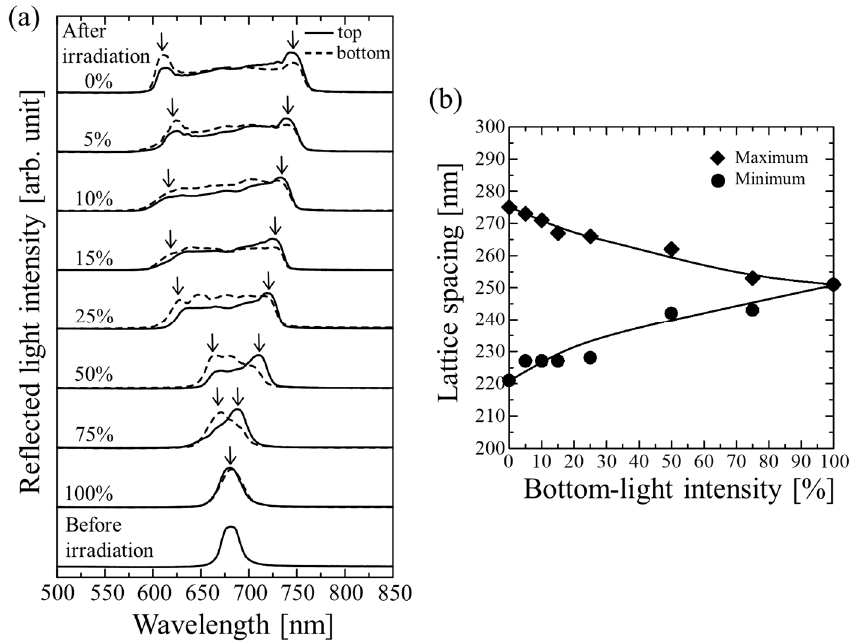
Figure 2. ( a ) Reflection spectra of gel-immobilized colloidal crystal films prepared using different bottom-light intensities as measured from top and bottom. Arrows indicate the positions of short- and long-wavelength sides of peaks. ( b ) Estimated maximum and minimum lattice spacings in the thickness direction as functions of bottom-light intensity.